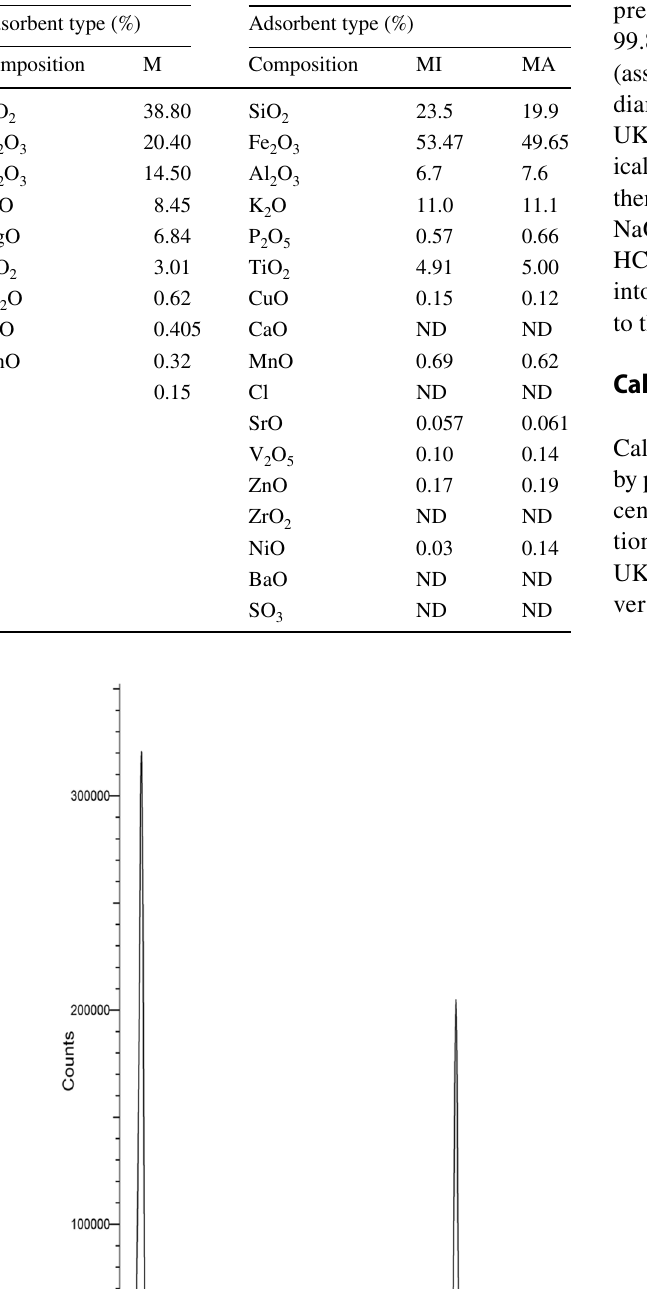
Table 1 Elemental composition of mica before and after coalescing obtained from XRF analysis Before coalescing